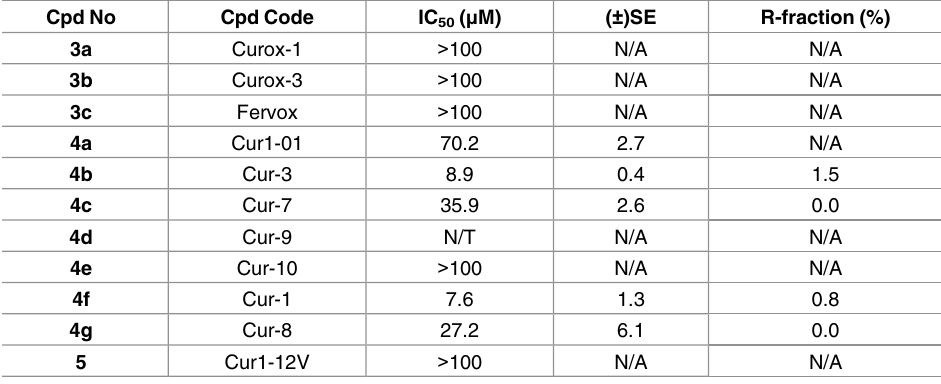
Table 2. Cytotoxic Activity of synthesized compounds against LS174T CRC cell lines.